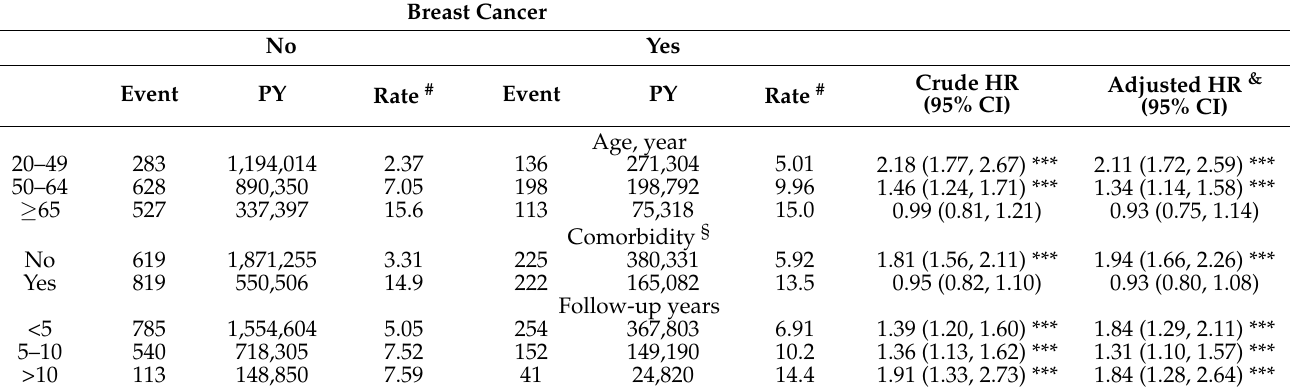
Table 3. Incidence and hazard ratios of lung cancer between individuals with and without breast cancer. Breast